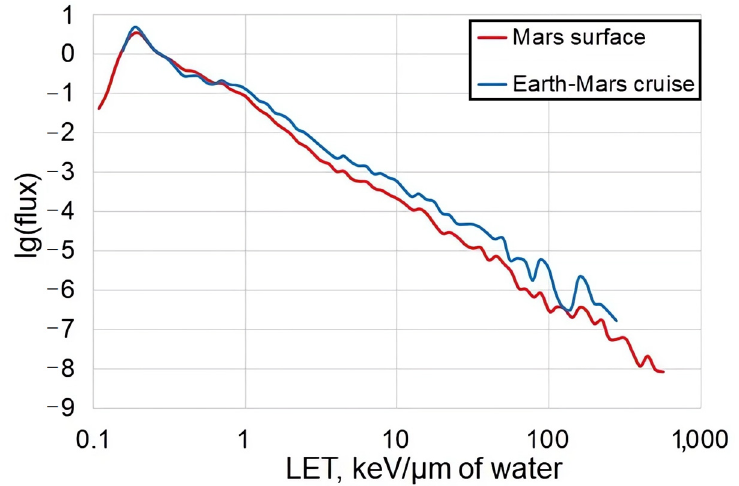
Figure 2. Comparison of charged particle LET spectrum measured on the Mars surface (red) to that measured during Earth–Mars cruise inside the MSL spacecraft (blue) with variable shielding. The data are presented as the decimal logarithm of the particle flux. Logarithmic scale on X axis was applied. LET—linear energy transfer. Primary data taken from [33] .